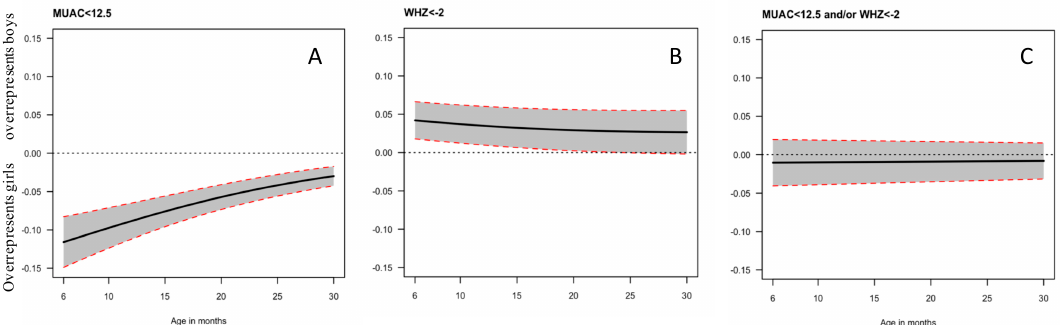
Figure 1. Effect of gender on the probability of being diagnosed with acute malnutrition when using mid-upper arm circumference (MUAC) only ( A ), weight-for-height Z-score (WHZ) only ( B ) or both indicators ( C ). An overrepresentation of girls is reflected by a curve below zero, whereas an overrepresentation of boys is reflected by a curve above zero.